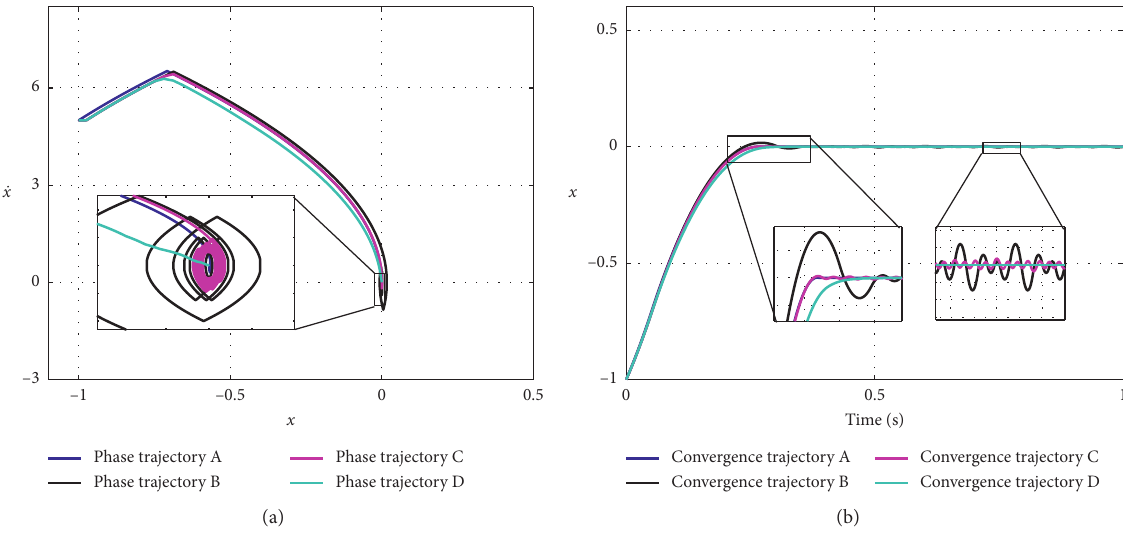
� h , and (D) timing control 0